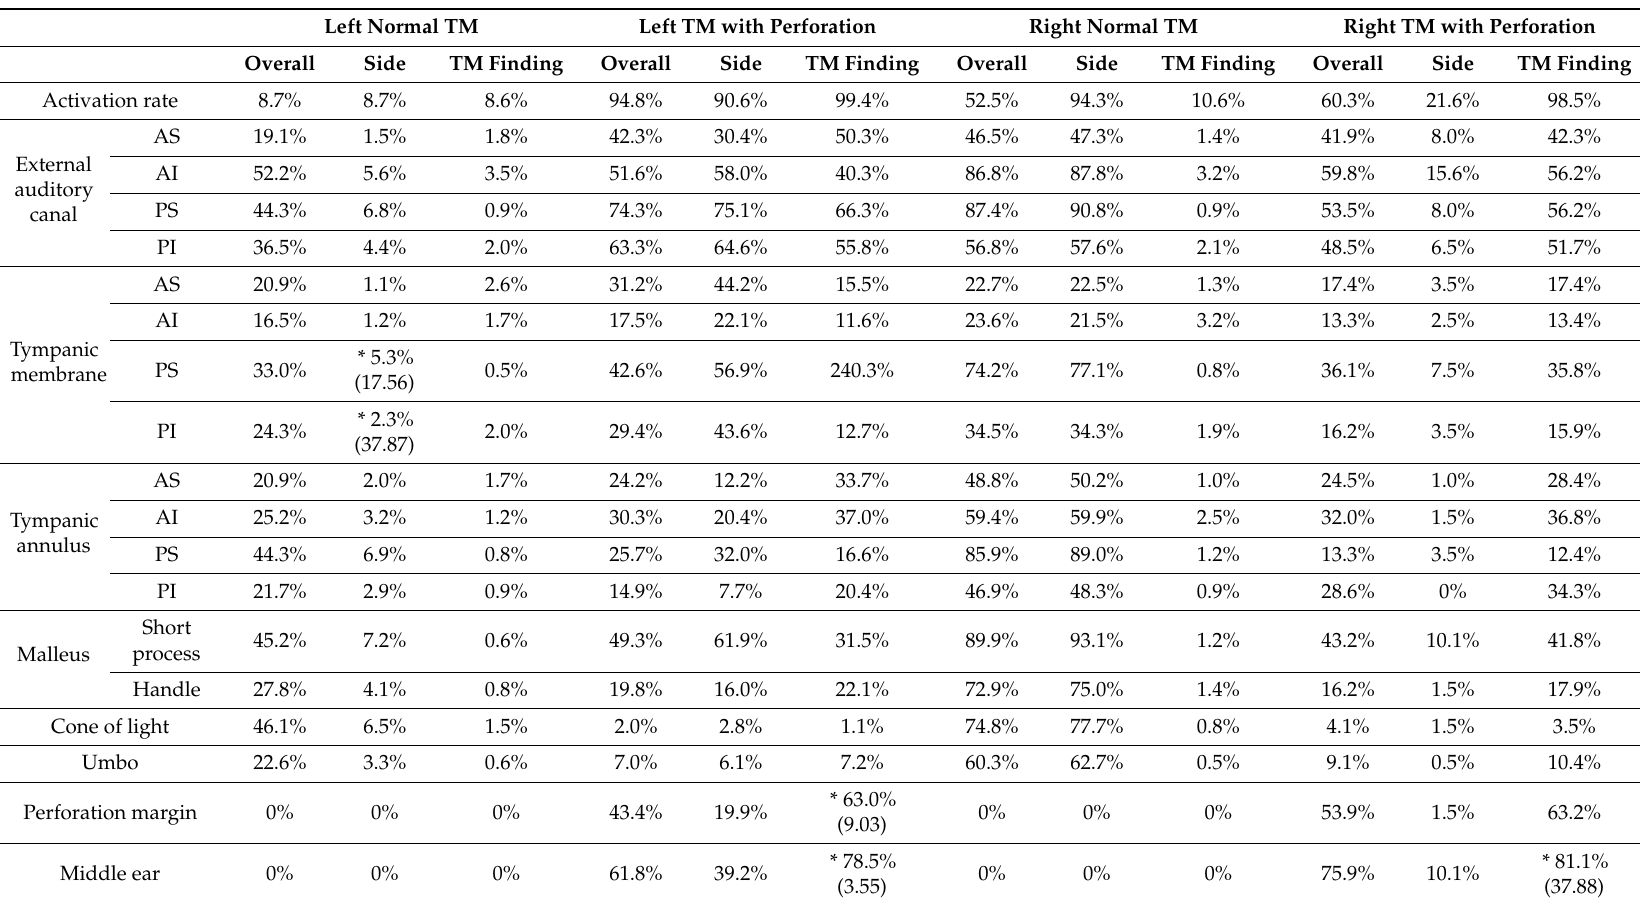
Table 3. Activation rate of subsite in class activation